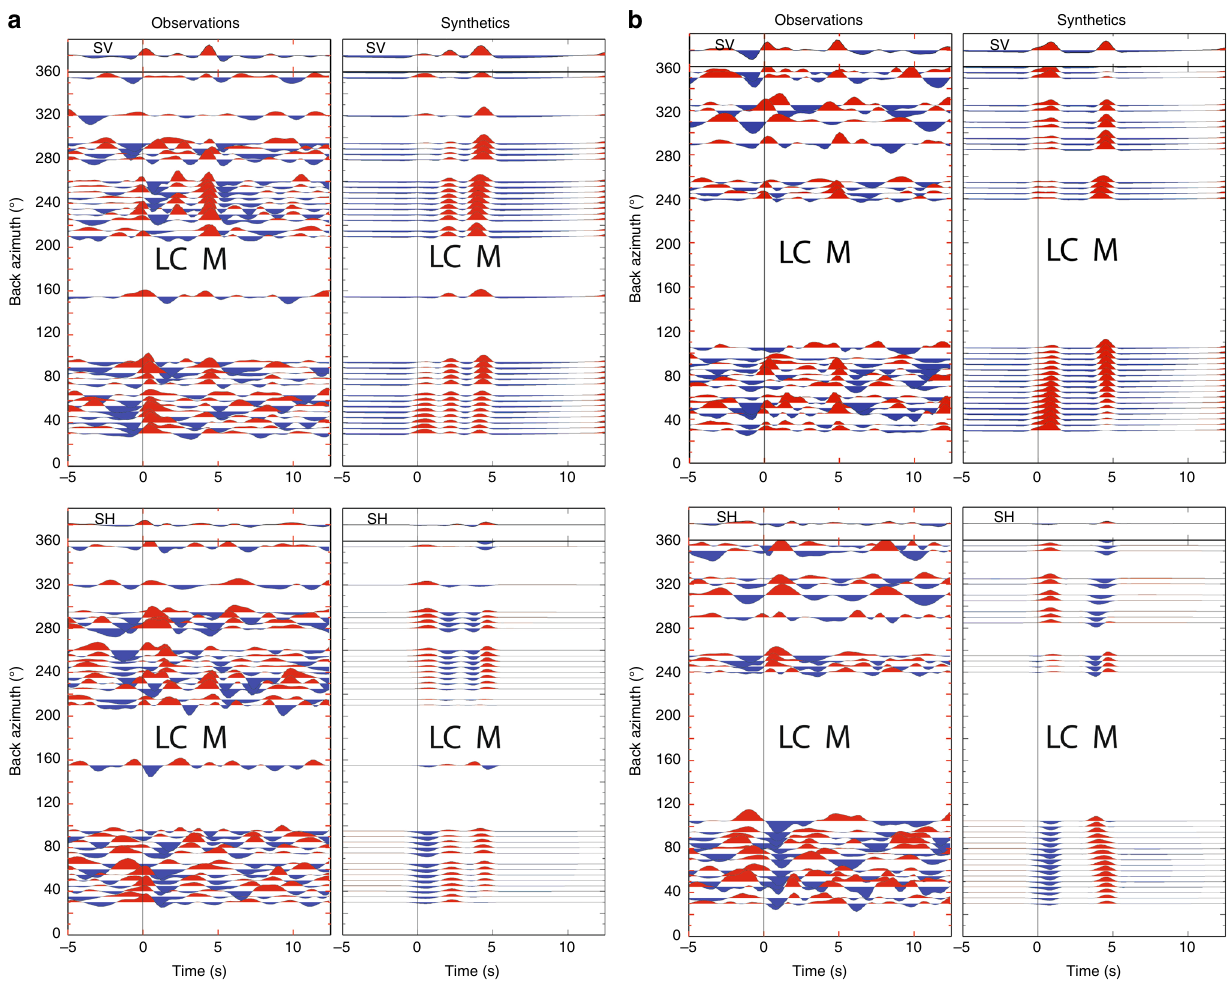
Fig. 4 Transverse P SH and radial P SV receiver functions versus back azimuth for the Kaapvaal Craton ( a — station SA25) and Limpopo Belt ( b — station SA55) and synthetic receiver functions calculated for the models in Table 1 (stacked in 5° bins). LC — top lower crust conversion, M — Moho conversion. Supplementary Figs. 1 – 4 show similar results based on stacked RFs for all stations in the corresponding tectonic